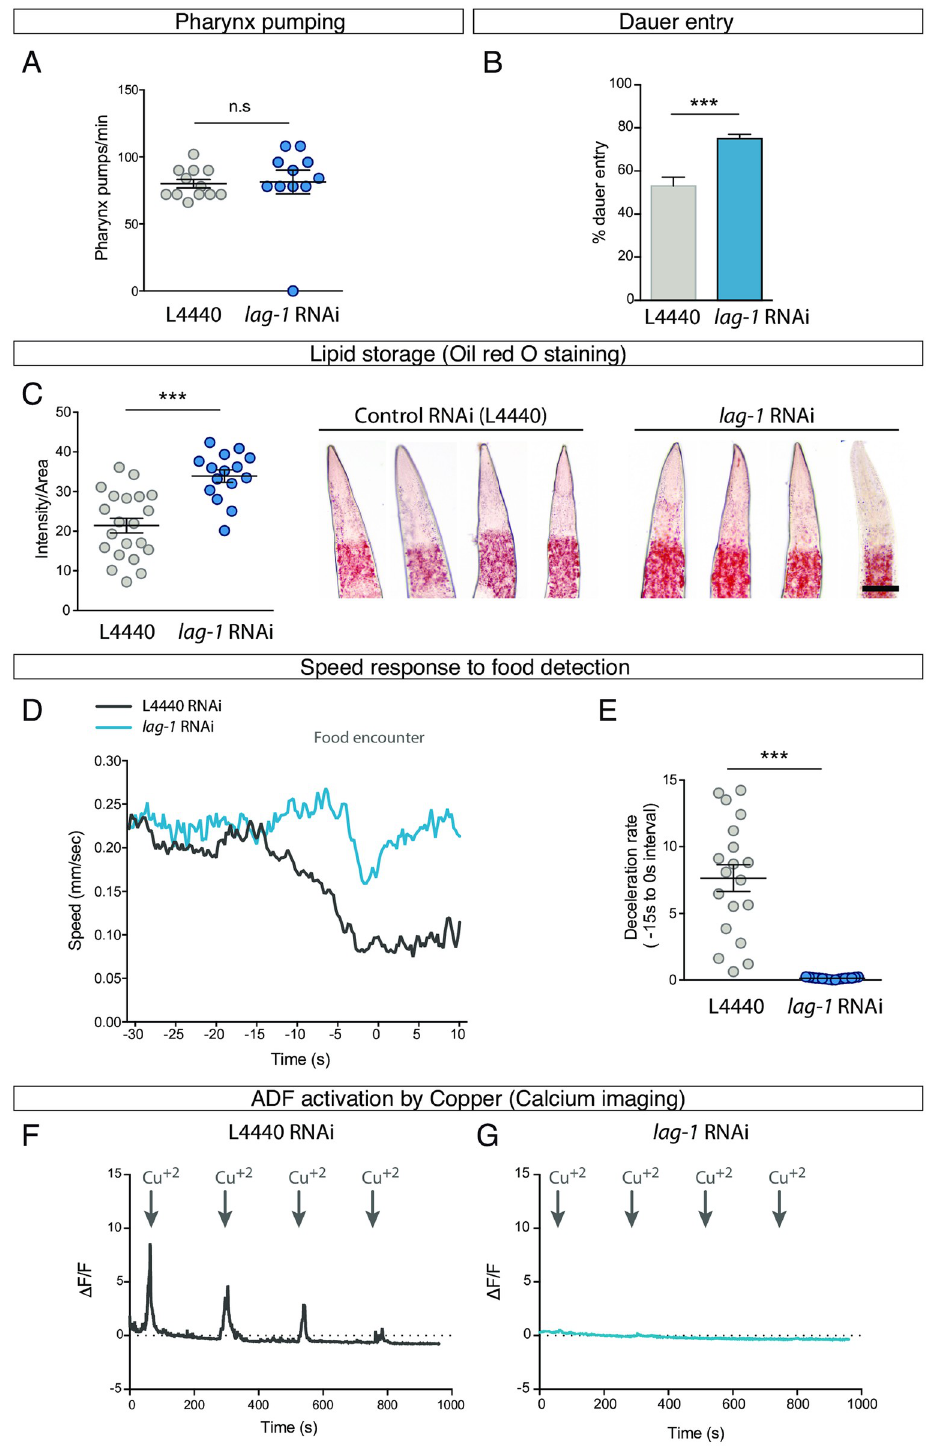
Fig 5. ADF-mediated processes require postembryonic LAG-1 function. (A) lag-1 P0 RNAi-fed worms show no defects in pharyngeal pumping rate. n � 10. Mean and SEM are represented. See S1 Data for raw data of all replicates. See S1 Data for numerical values. (B) lag-1 P0 RNAi-fed worms show a significant increase in dauer induction by pheromones compared to control RNAi. n = 148 worms in controls and n = 474 in lag-1 RNAi. Percentage and SEP are represented. See S1 Data for raw data of all replicates. See S1 Data for numerical values. (C) lag-1 P0